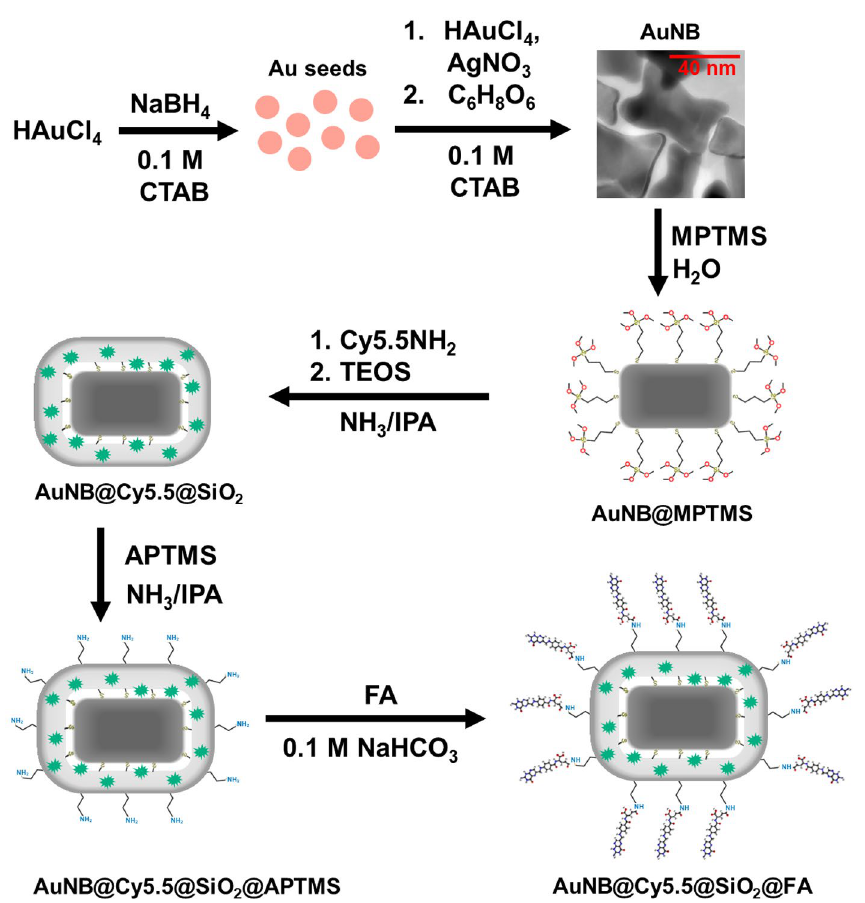
Figure 1. Scheme of the nanotags preparation including a synthesis of anisotropic gold nanoparticles, their labeling with a fluorophore, coating with a silica shell, and modification with a delivery vector.